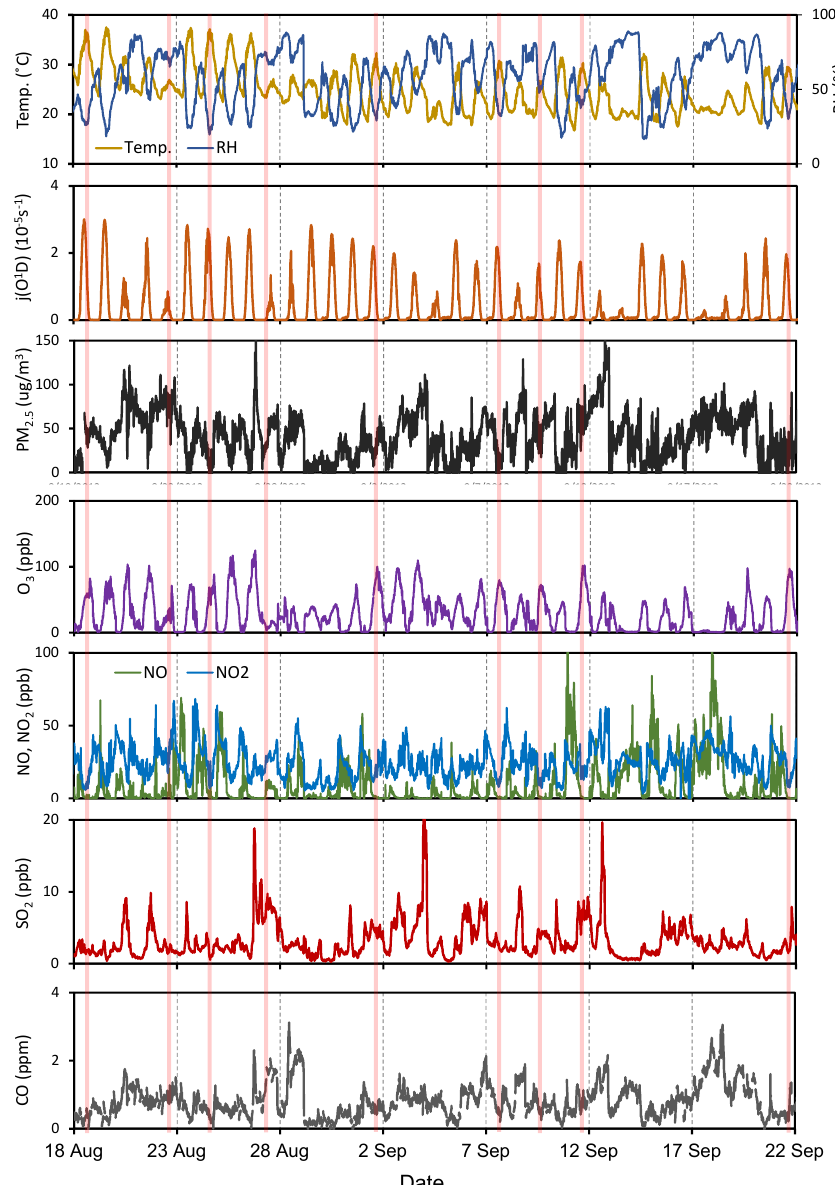
Figure 7. Time series of ambient pollutant concentrations and meteorological parameters during the experimental period in Beijing. Red bars indicate periods when BC ageing experiments were